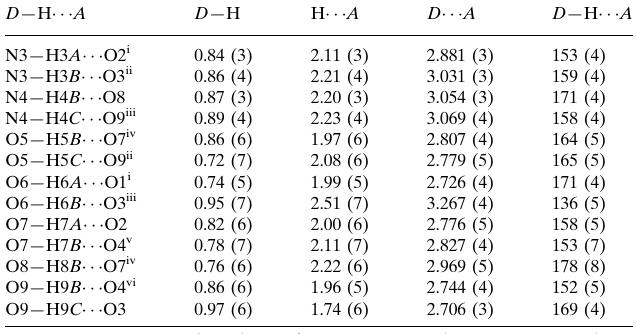
Hydrogen-bond geometry (A˚ , (cid:2) ). D —H (cid:1)(cid:1)(cid:1)